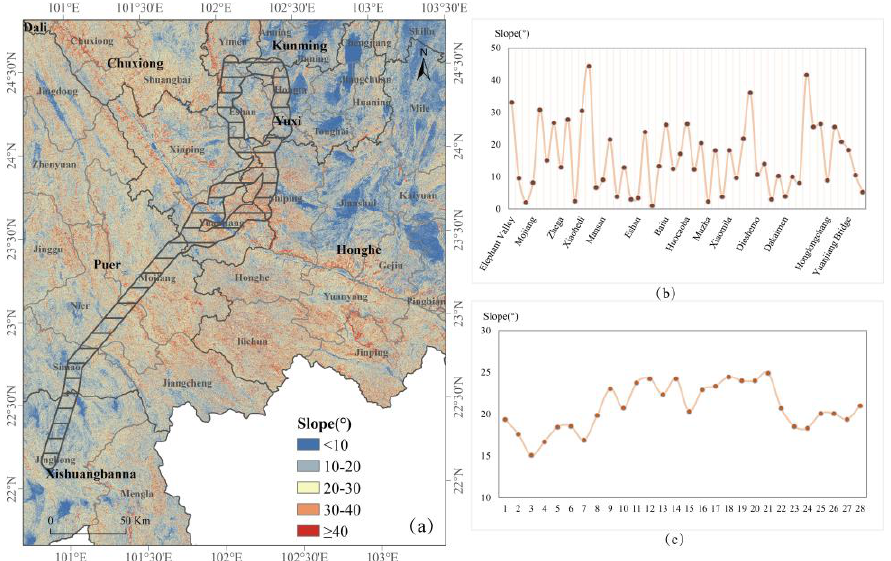
Figure 2. Slope of the 2021 Asian elephant movement route. The figure was composed of three parts: ( a ) the spatial pattern of slope, ( b ) the slope change curve of recorded locations, and ( c ) the slope change curve of the buffer grid from south to north.